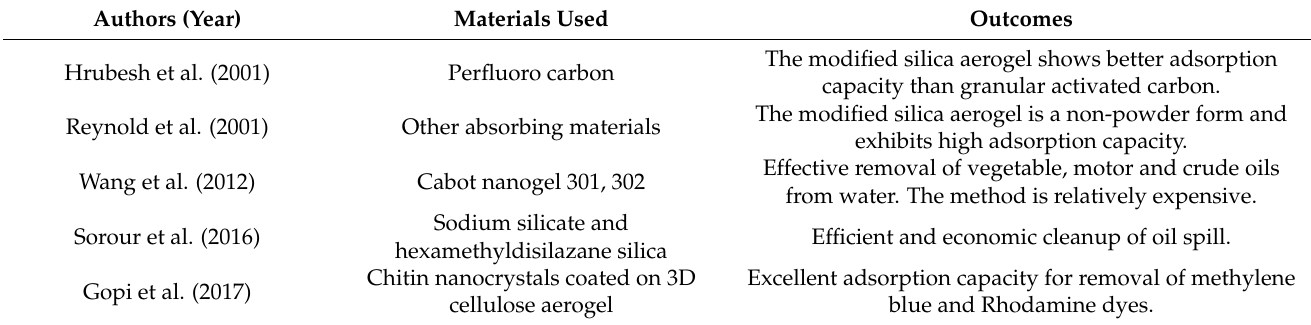
Table 7. Recent studies on modified silica aerogel for adsorptive applications.